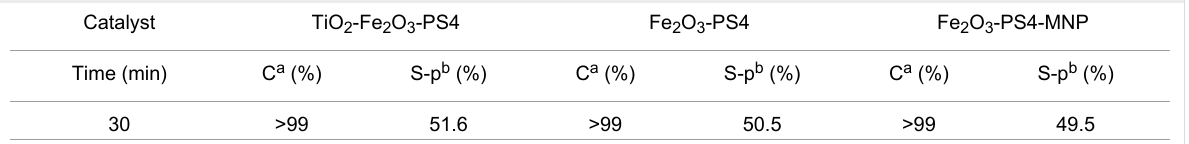
Table 7: Conversion and selectivity of the alkylation of toluene with conventional